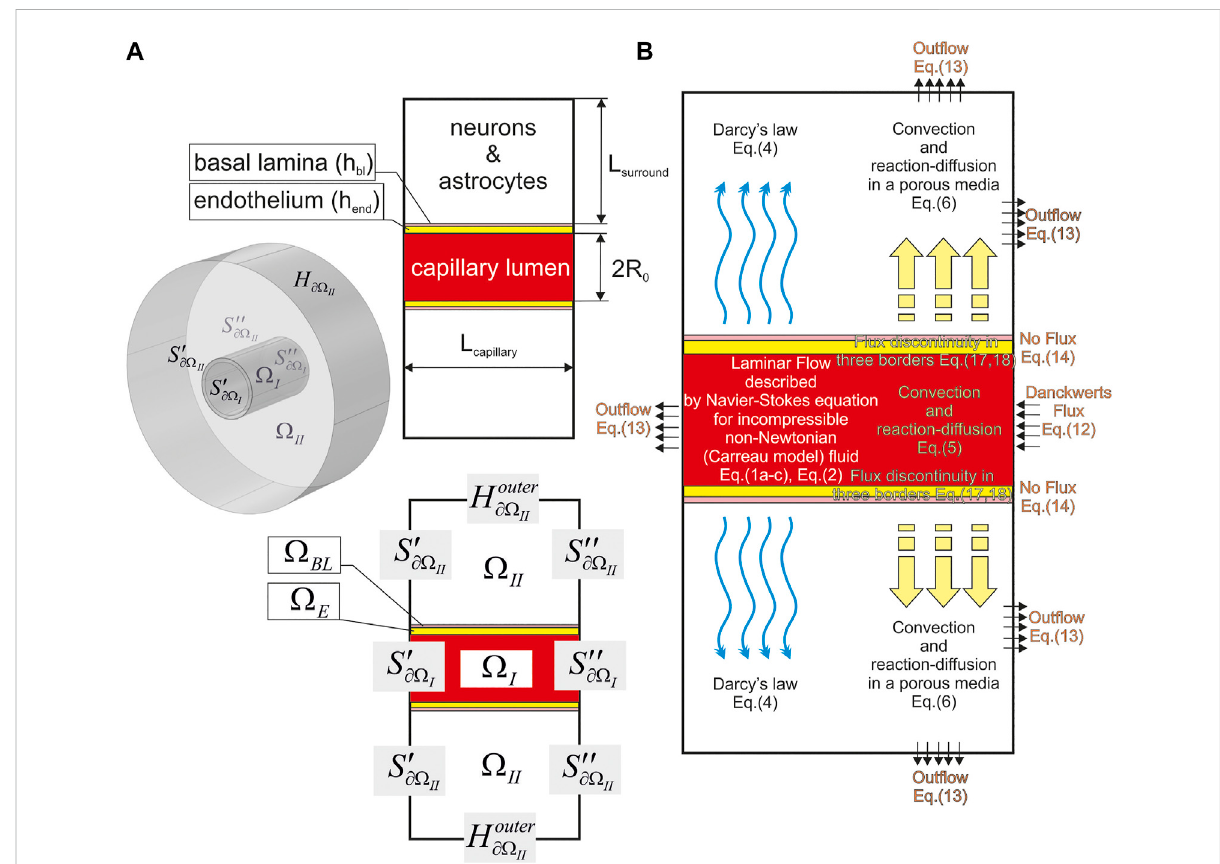
FIGURE 2 A geometryof theused digital NVUphantom.The main parametersare indicated onthe plane projection (A) and the indication of thephantom parts and surfaces are shown both in an isometric drawing [The left part of (A) ] and the plain view [The bottom part of (A) ]. It is assumed that (cid:1) H inner ; H outer (cid:1) H inner ; H outer (cid:1) H inner H z Ω z Ω E z Ω E z Ω BL z Ω BL z Ω II . The distributionof physicalprocesses with referencednumber of the equations is represented in all parts I of Ω (B) (see the